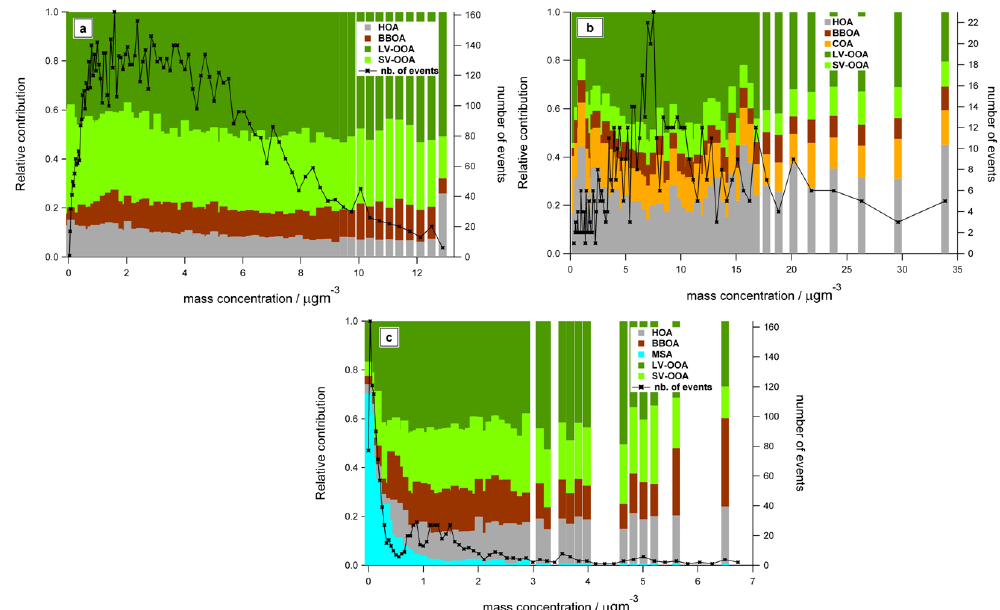
Figure 5. Relative organic source contributions as a function of total organic concentrations. Average plot over all the seasons and rural sites (a) , Barcelona only (b) , and average plot for marine sites (c)